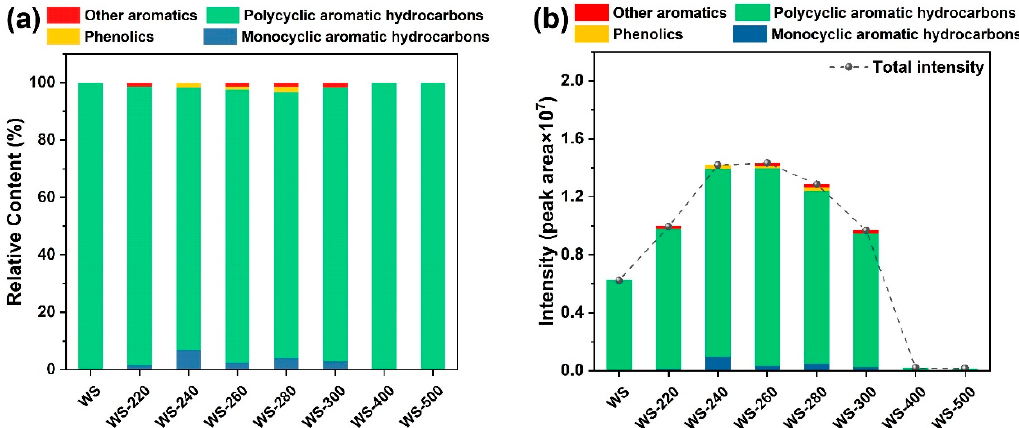
Figure 7. Tar elimination behaviors from steam gasification of raw WS and WS treated at varying temperatures: ( a ) relative contents of aromatics in tar and ( b ) intensities of aromatics in